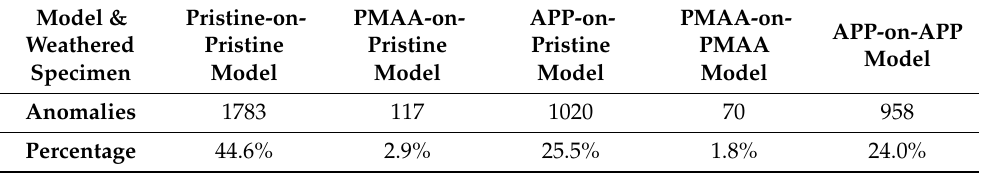
Table 2. Quantified results by deep learning on the weathered specimens.